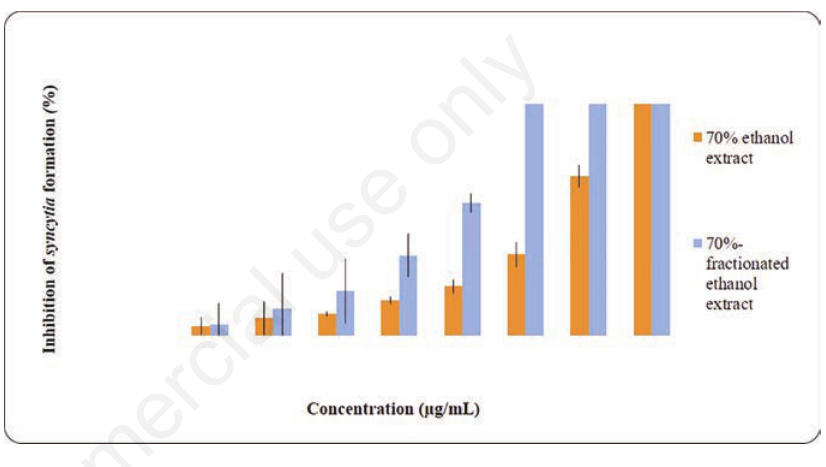
Figure 3. The percentage of syncytia formation inhibition on HIV-infected MOLT-4 cells of 70% fractionated-ethanol extract and 70% ethanol extract from J. gendarussa leaves with various concentrations. It was measured after 72 hr incubation under conditions. Error bars show the standard deviation from average of three data.